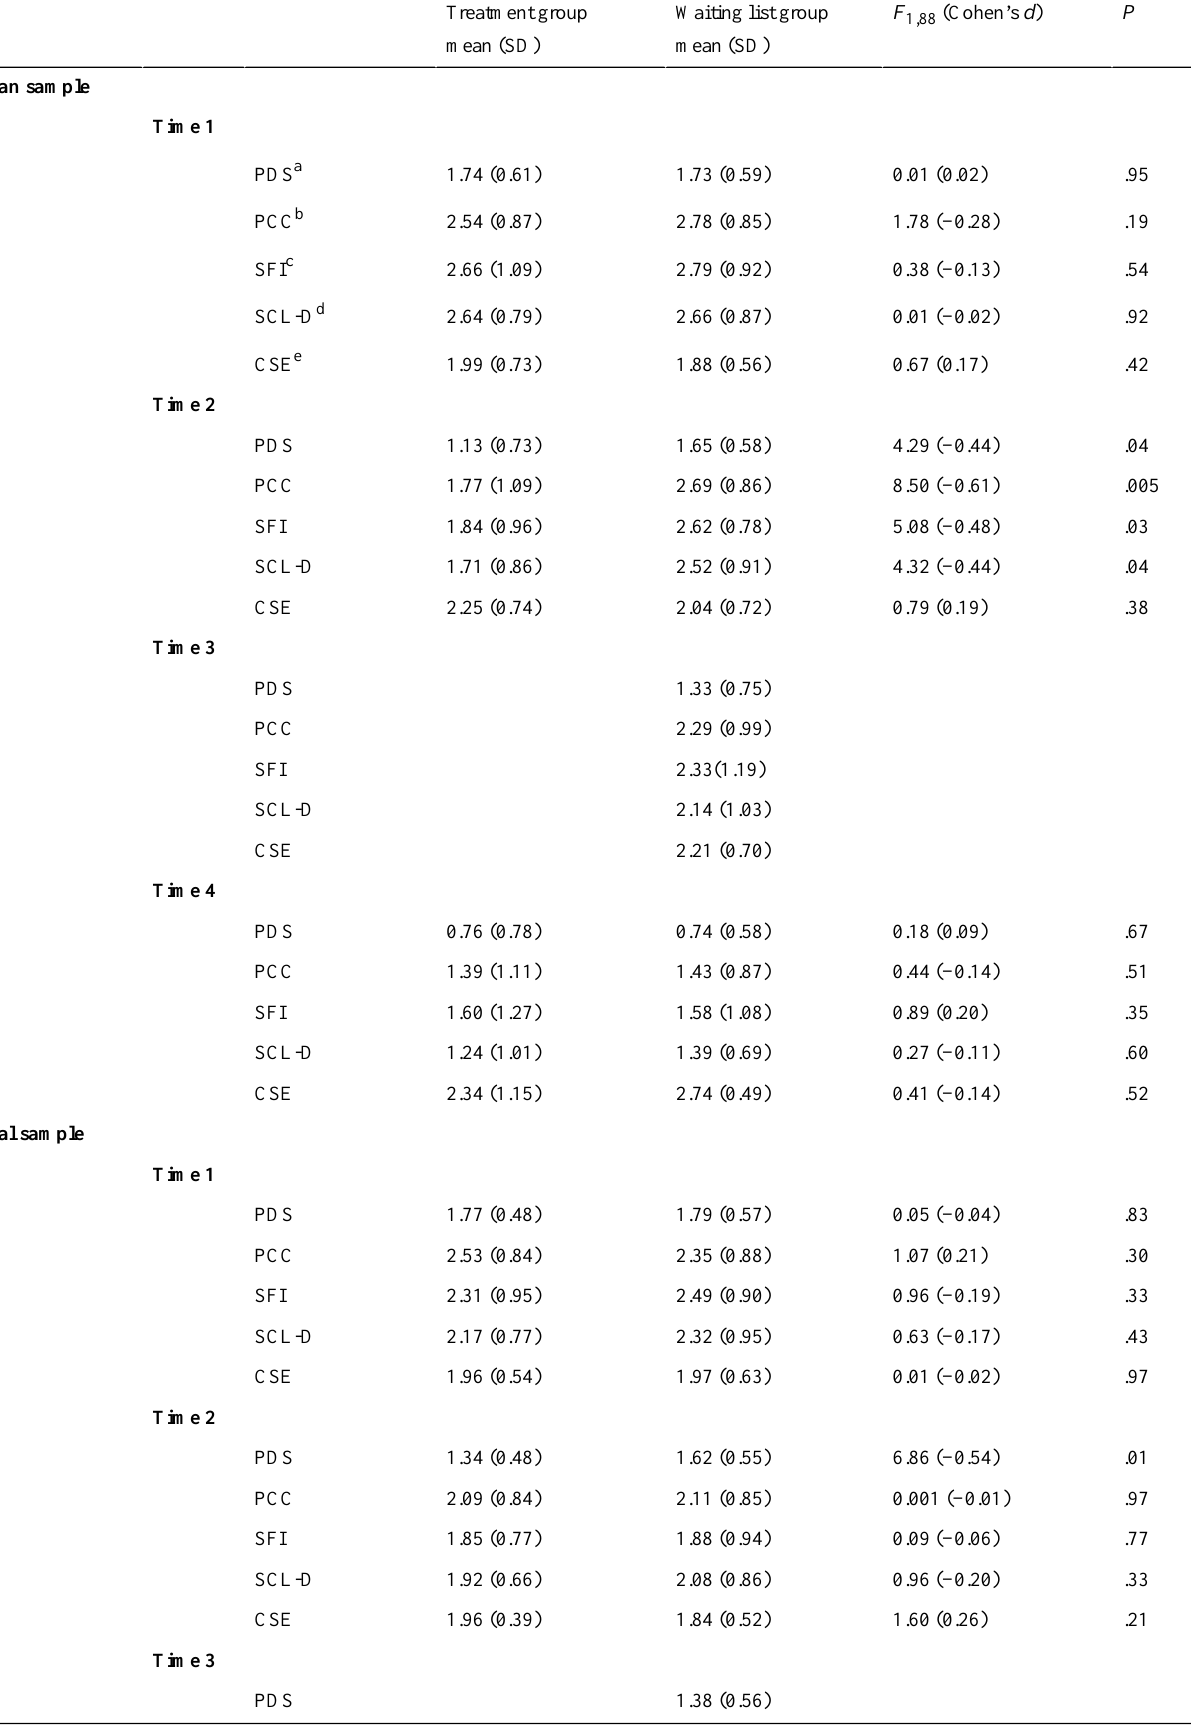
Table 2. Descriptive statistics, between-group comparisons, and effect sizes (Cohen’s d ) for each sample: intention-to-treat